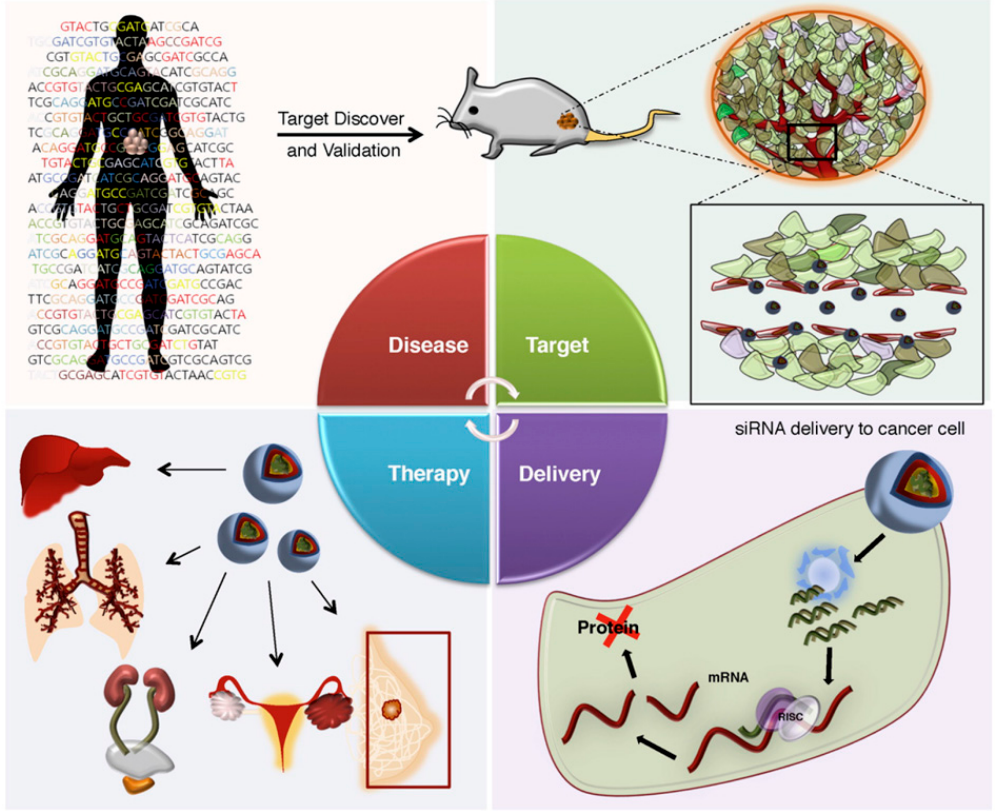
Figure 2. Designing siRNA therapeutics for cancer treatment (Reproduced with permission from [14], Copyright Elsevier,